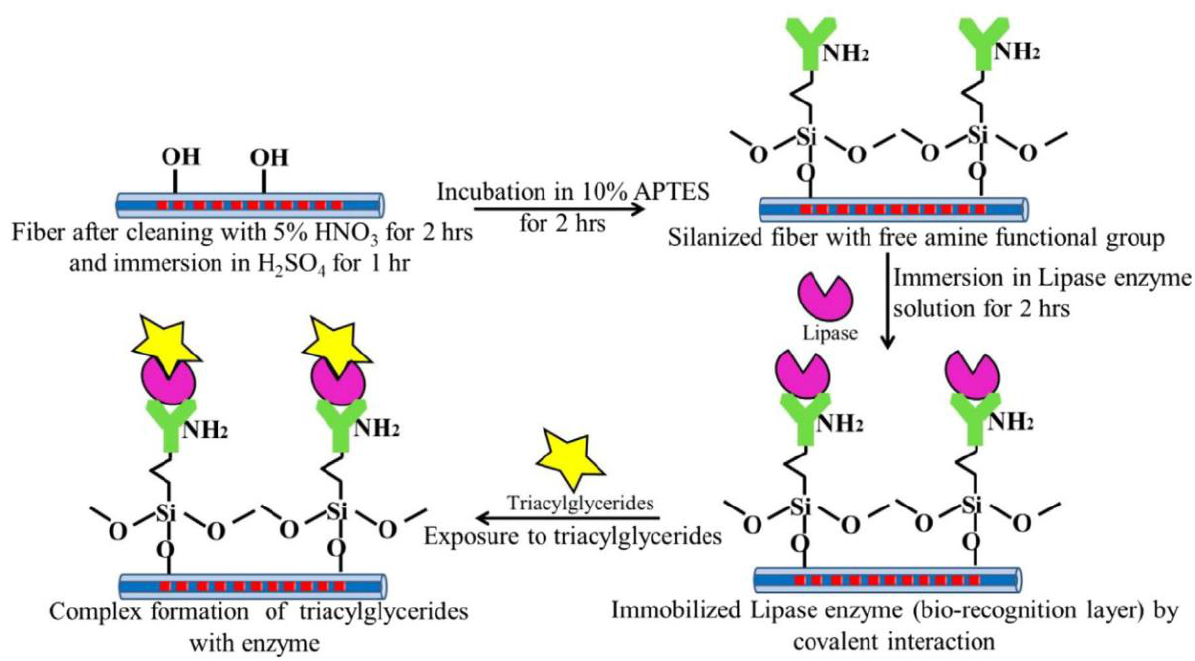
Figure 9. Immobilization of enzymes to create the bio-recognition layer on the optical fiber probe. Reprinted with permission from [80]. Copyright © 2015 Elsevier B.V.